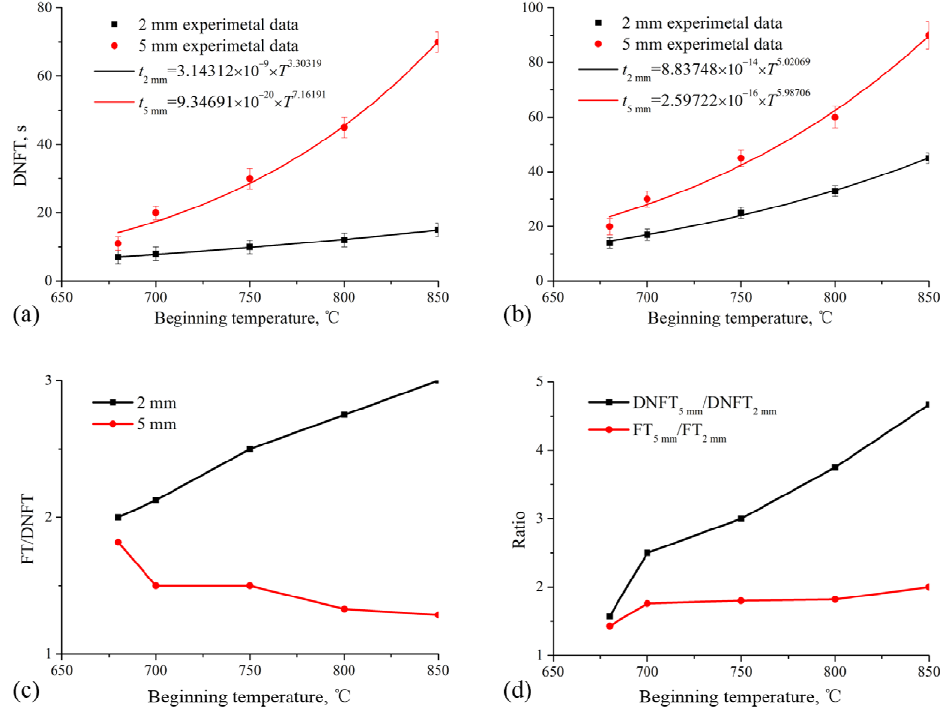
Figure 5. The different solidification stages’ dependence on the beginning temperature for the two geometries of thin-walled samples. ( a ) Dendrite network forming time (DNFT); ( b ) feeding time (FT); ( c ) ratios of FT/DNFT; and ( d ) ratios of DNFT 5 mm /DNFT 2 mm and FT 5 mm /FT 2